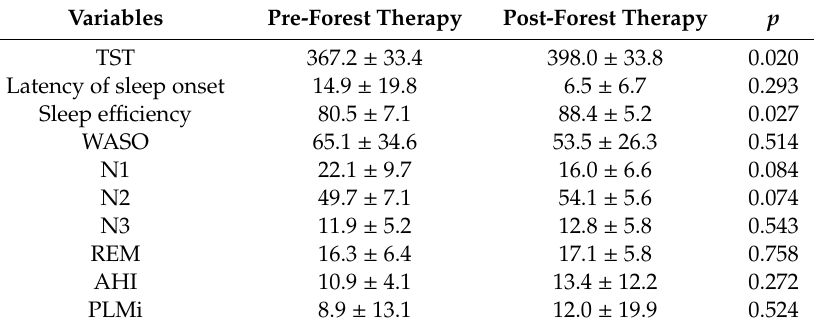
Table 2. Polysomnography findings.